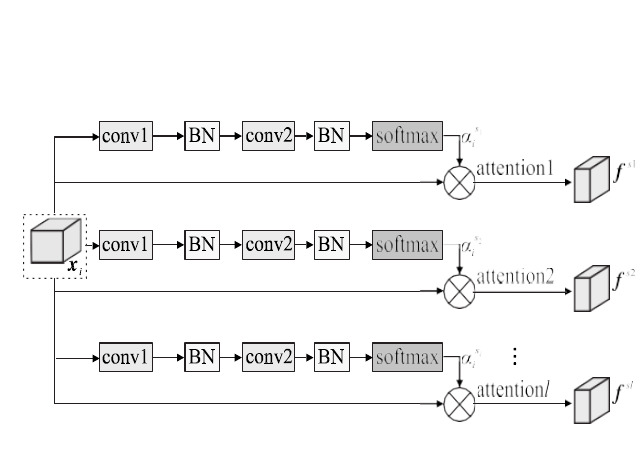
Figure 4. Multi-spatial attention